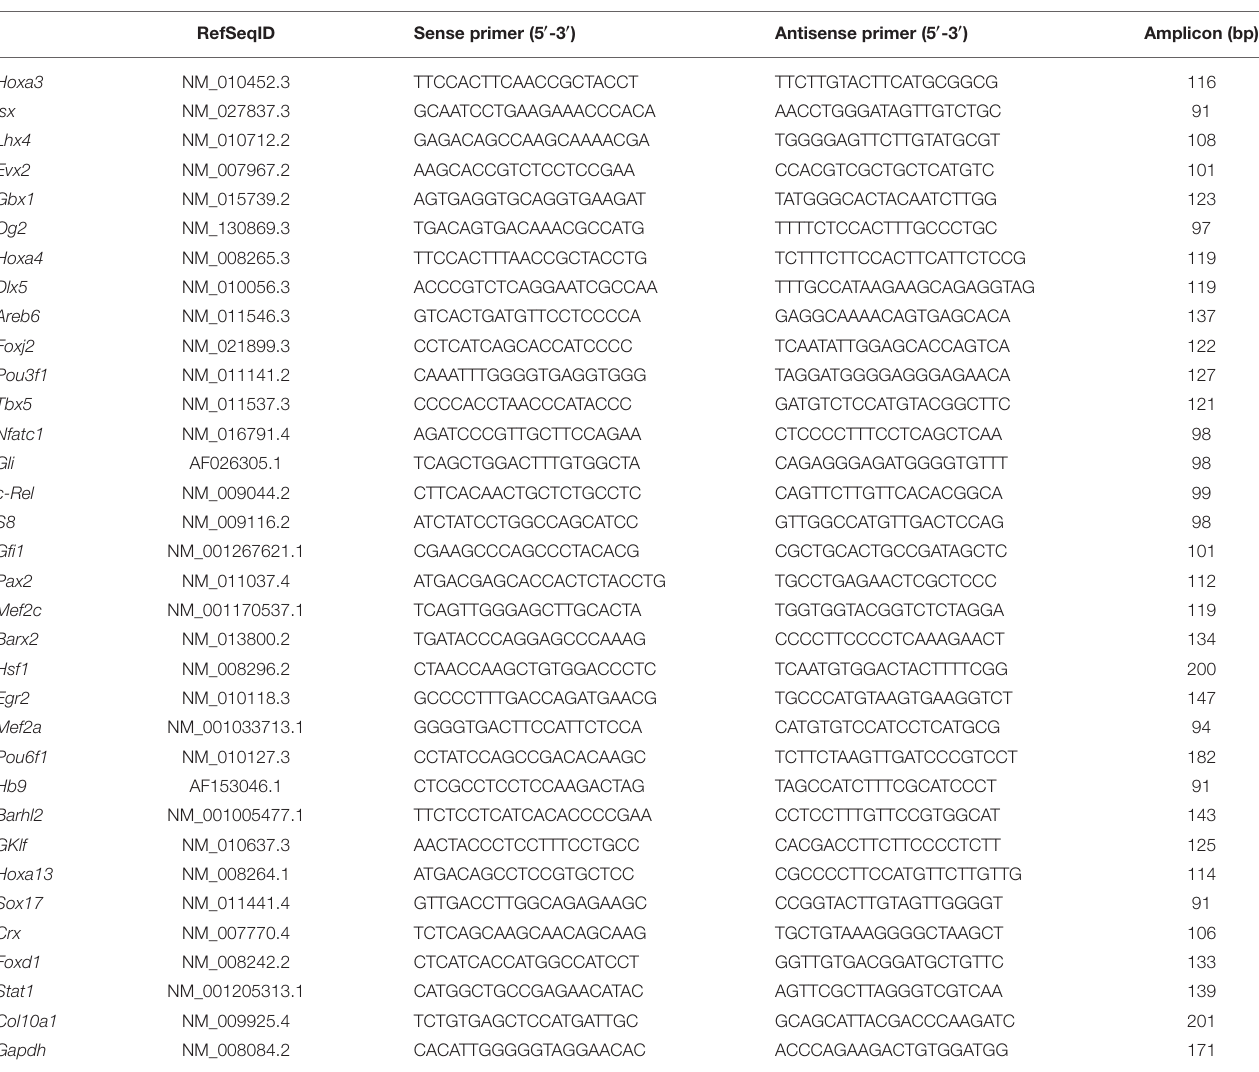
TABLE 1 | The primers in real-time